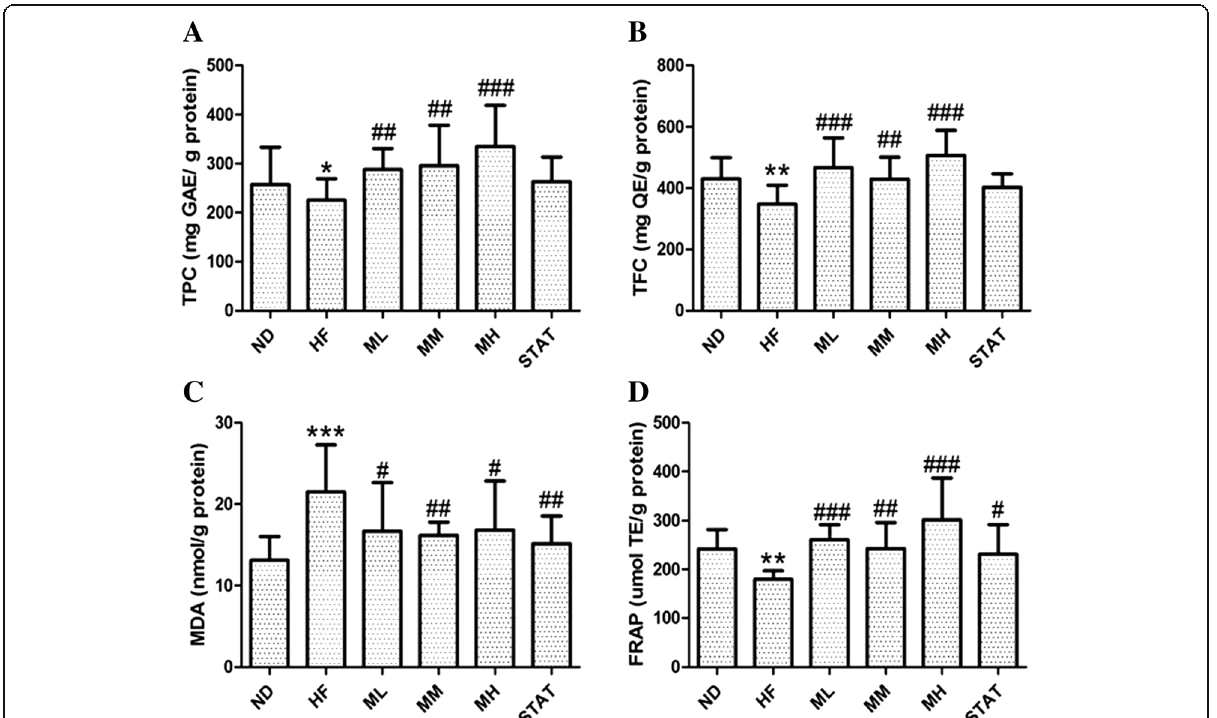
Fig. 1 Total phenolic content ( a ), total flavonoid content ( b ), malondialdehyde level ( c ) and Ferric reducing antioxidant power (FRAP) level ( d ) in the cardiac tissue. Data are expressed as mean±SD, n =12. ND: standard diet, HF: high fat diet, ML, MM, MH: high fat diet with Mao Luangcrude extract 0.38 or 0.76 or 1.52g/kg, respectively, STAT: high fat diet with simvastatin 10mg/kg.* p <0.05, ** p <0.01, *** p <0.001 represent significant differences when compared with the ND group. # p <0.05, ## p <0.01, ### p <0.001 represent significant differences when compared with the HF